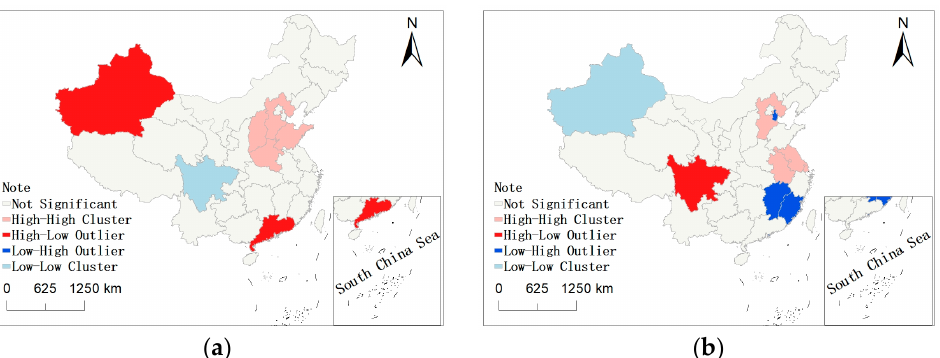
Figure 4. ( a ) LISA chart of total carbon emissions in 2018; ( b ) LISA chart of financial employment in 2018.